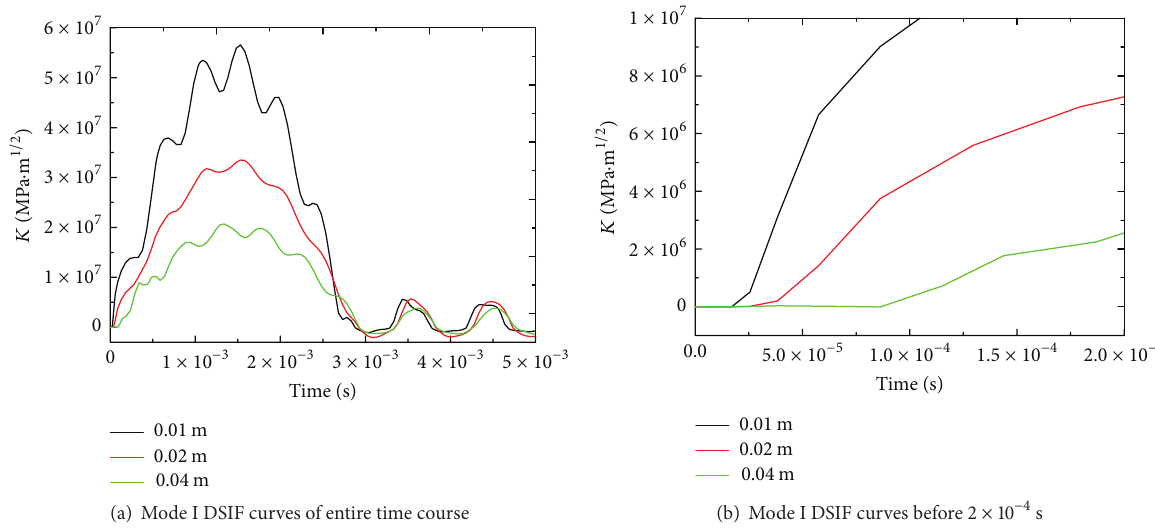
Figure 11: Mode I DSIF curves at node 1 with different fixed crack lengths under the impact velocity of 5m/s.